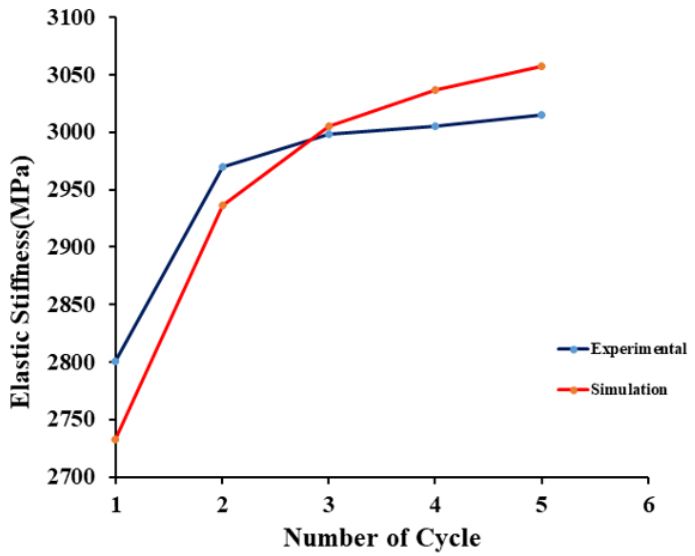
Figure 10. ES changes diagram in terms of the number of cycles (experiment and numerical simula- tion).